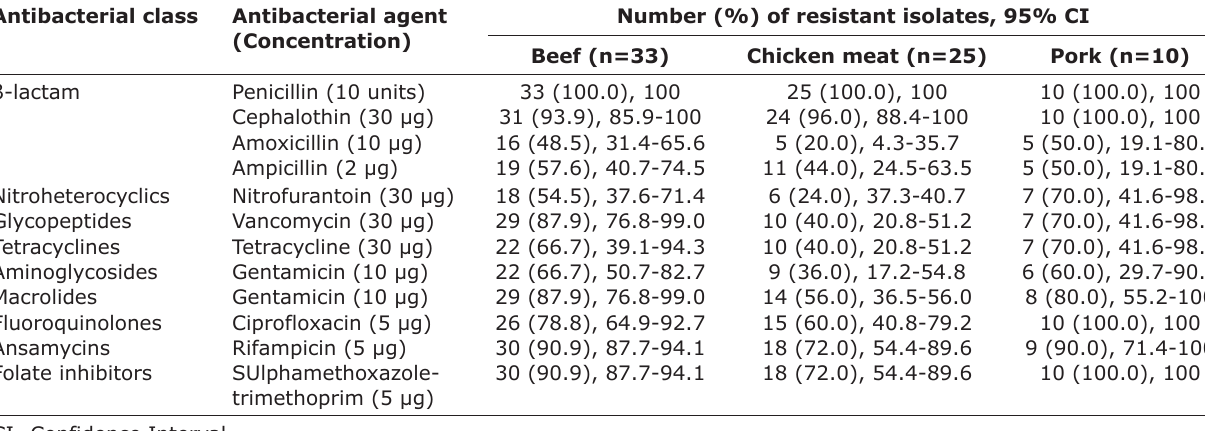
Table-2: Antibacterial susceptibility profile of Listeria isolates from raw meats marketed in Enugu State Southeast Nigeria. Antibacterial